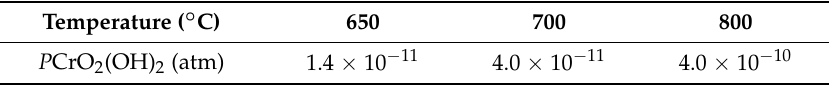
Table 4. P CrO 2 (OH) 2 in steam at 650–800 ◦